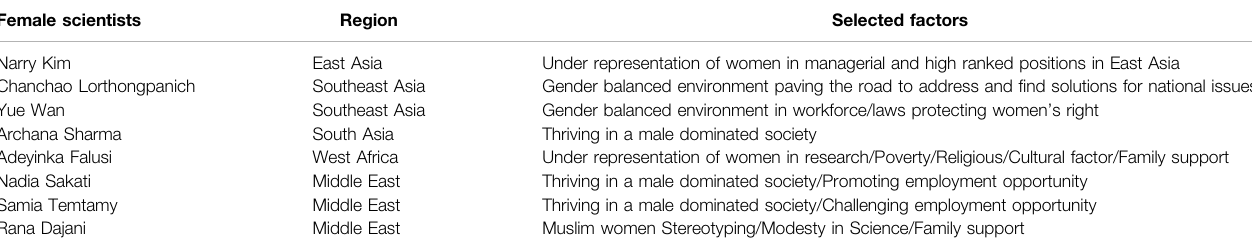
TABLE 2 | Summarizing our selected scientists and some of the in fl uential factors that affected their career progress. Female